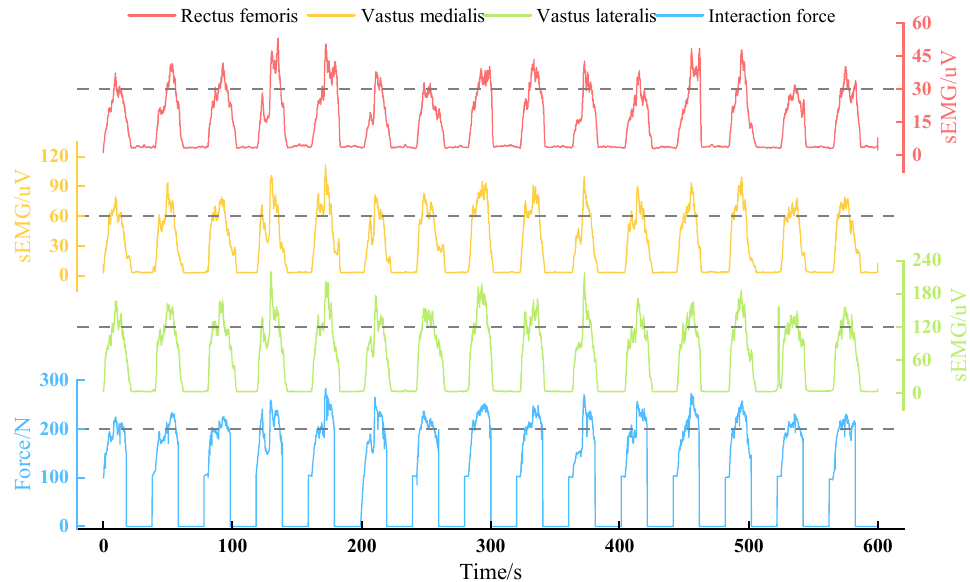
Figure 10. Changes of EMG and interaction force during the training (Dashed line for value refer- ence).